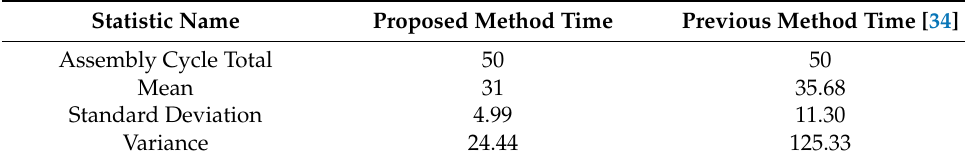
Table 11. Duration of Each Cycle in the Chair Assembly Process.